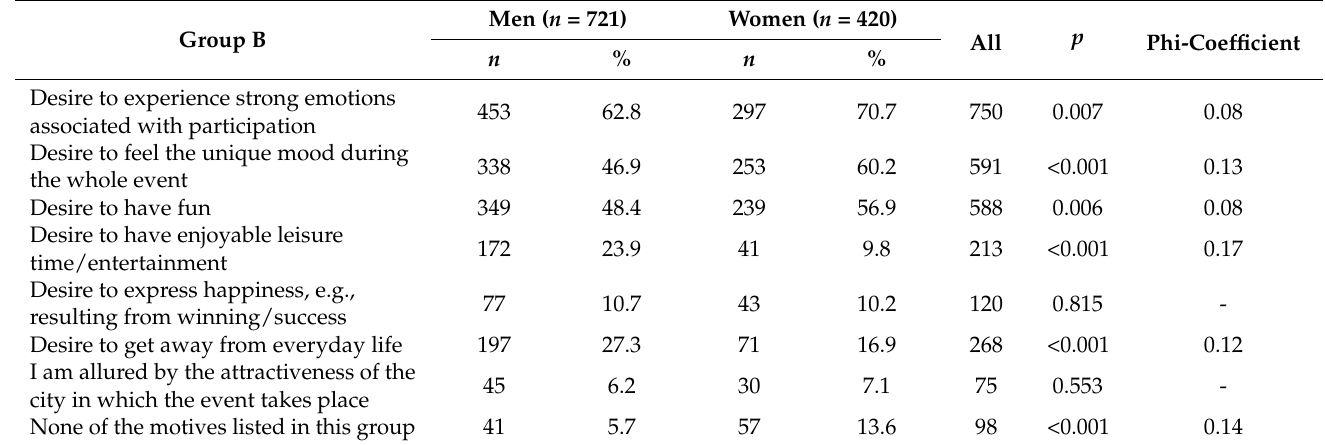
Table 3. Motives within the scope of experience orientation.